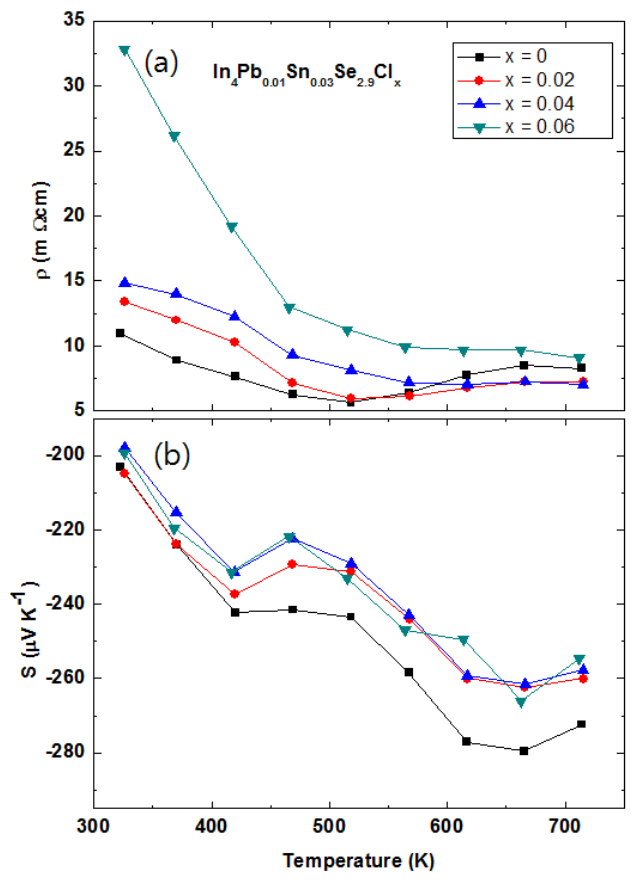
Figure 23. Temperature-dependent electrical resistivity ρ (T) ( a ) and Seebeck coefficient S(T) ( b ) of the In 4 Pb 0.01 Sn 0.03 Se 2.9 Cl x ( x = 0.0, 0.02, 0.04, and 0.06) polycrystalline compounds